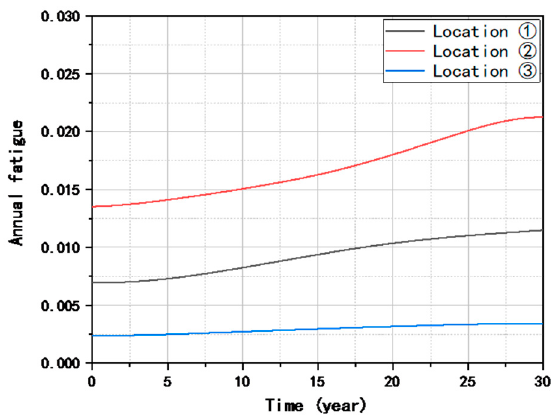
Figure 6. Finite-element model of the tripod foundation.